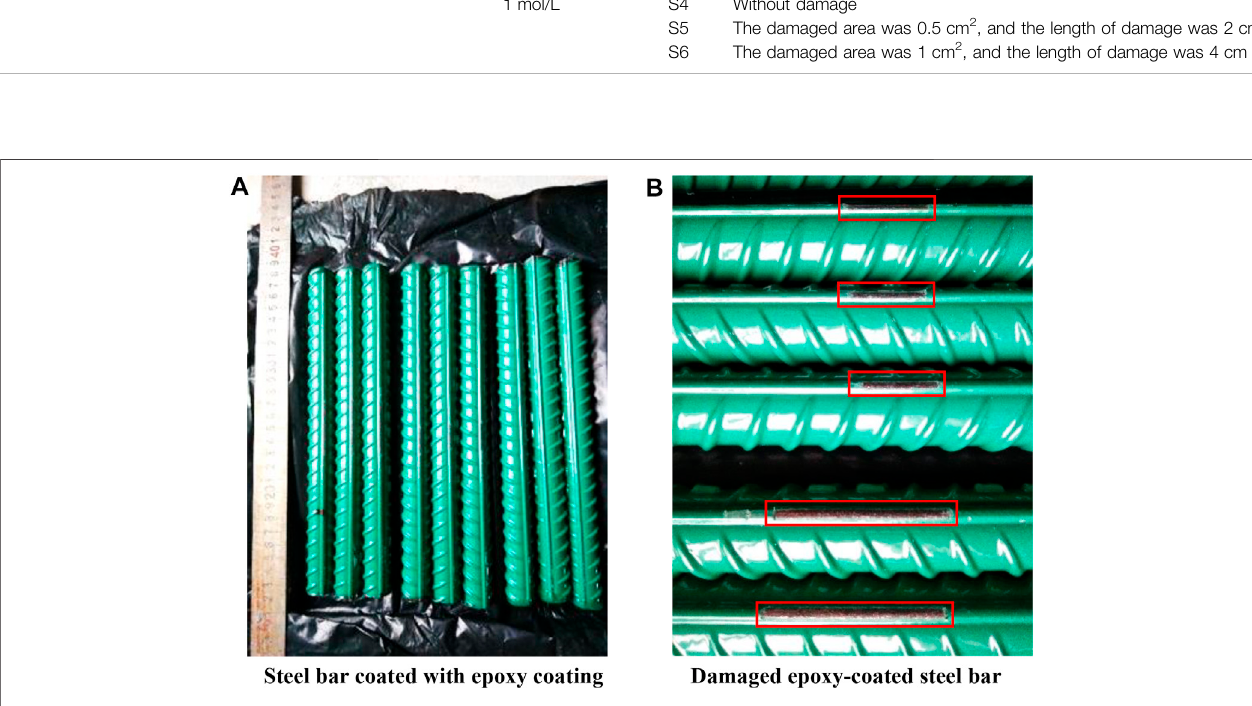
FIGURE 1 | Epoxy-coated steel bar specimen. (A) Steel bar coated with epoxy. (B) Damaged epoxy-coated steel bar.